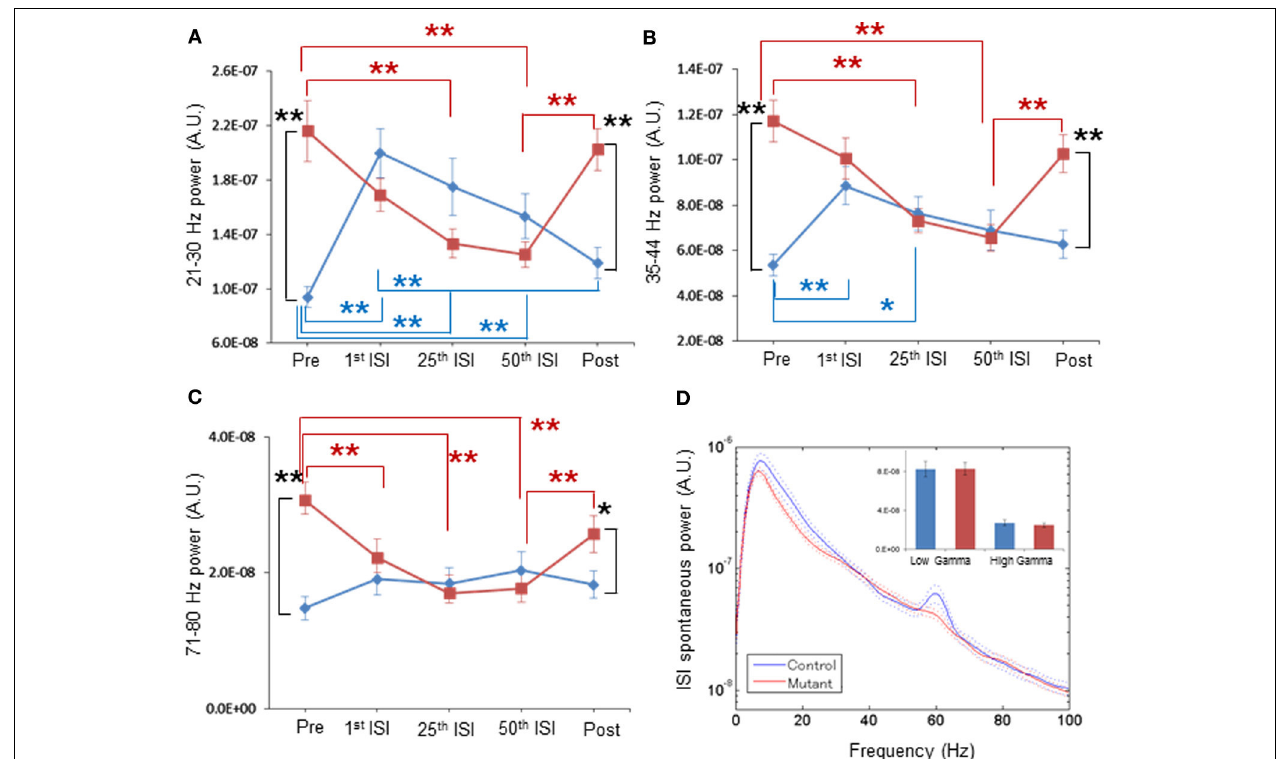
FIGURE 5 | Normal magnitude of baseline LFP power during periods of periodic ASSR stimuli, by per-channel design. (A) Mean normalized powers in per channel design for 21–30Hz frequency LFP fluctuation in control (blue, n = 31 sites from 7 animals) and mutant (red, n = 26 sites from 6 animals) mice during Pre-ASSR, 1st ISI, 25th ISI, 50th ISI, and post-ASSR. ∗∗ p < 0 . 01, repeated-measures ANOVA followed by post-hoc Bonferroni testing. (B) Mean normalized powers for 35–44Hz frequency LFP fluctuation in control (blue) and mutant (red) mice during Pre-ASSR, 1st ISI, 25th ISI, 50th ISI, and Post-ASSR. ∗∗ p < 0 . 01 and ∗ p < 0 . 05, repeated-measures ANOVA followed by post-hoc Bonferroni testing. (C) Mean normalized